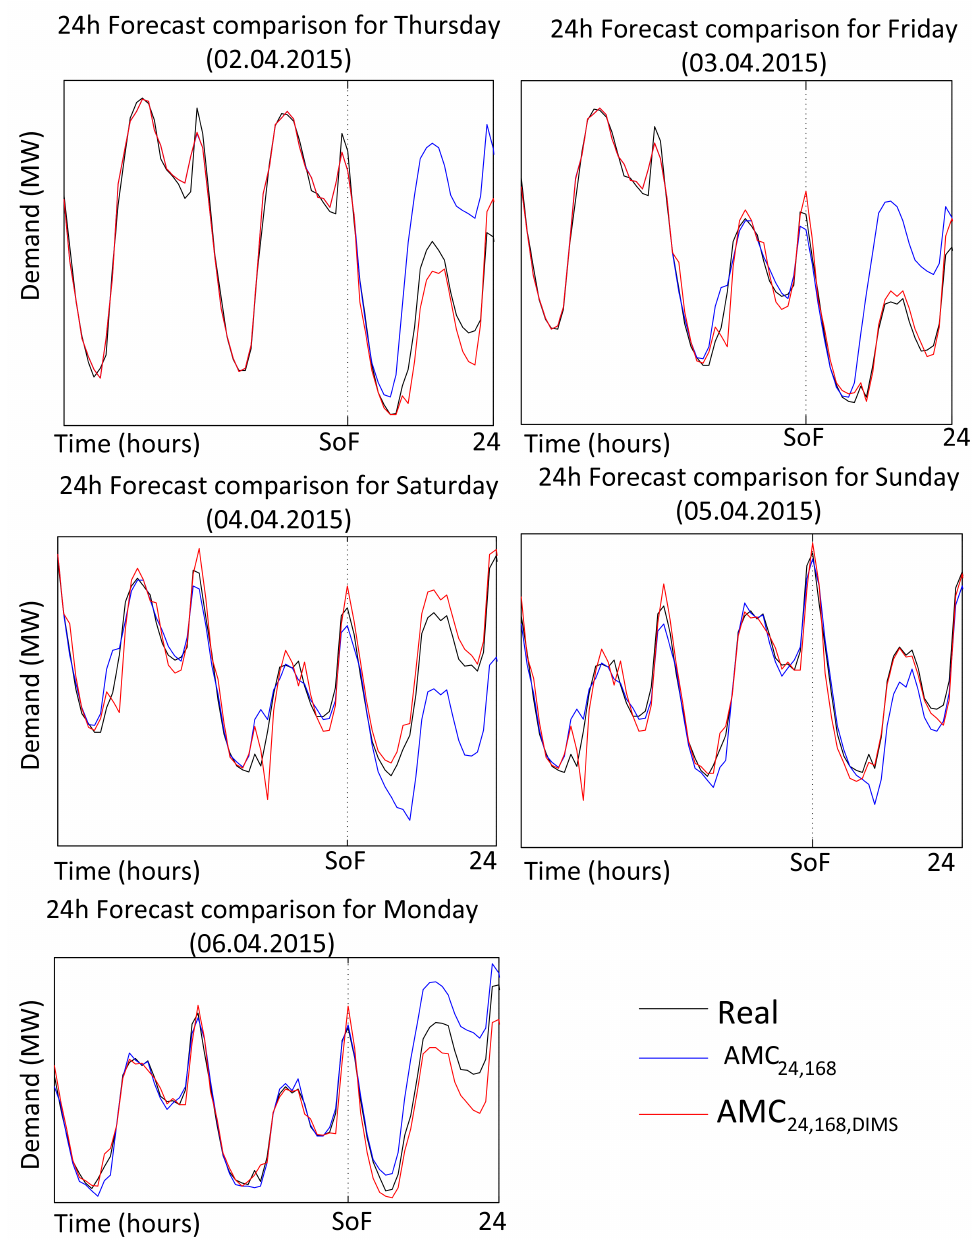
Figure 4. Comparison of 24-h-ahead forecasts obtained by the regular method and the DIMS method. The abscissa represents the lead time in hours from the start of the forecast (SoF) to 24 h ahead. The black line represents the real (observed values) with which the forecasts are compared. The blue line is the forecast obtained by the regular method; the red line is the forecast obtained by the new DIMS method.